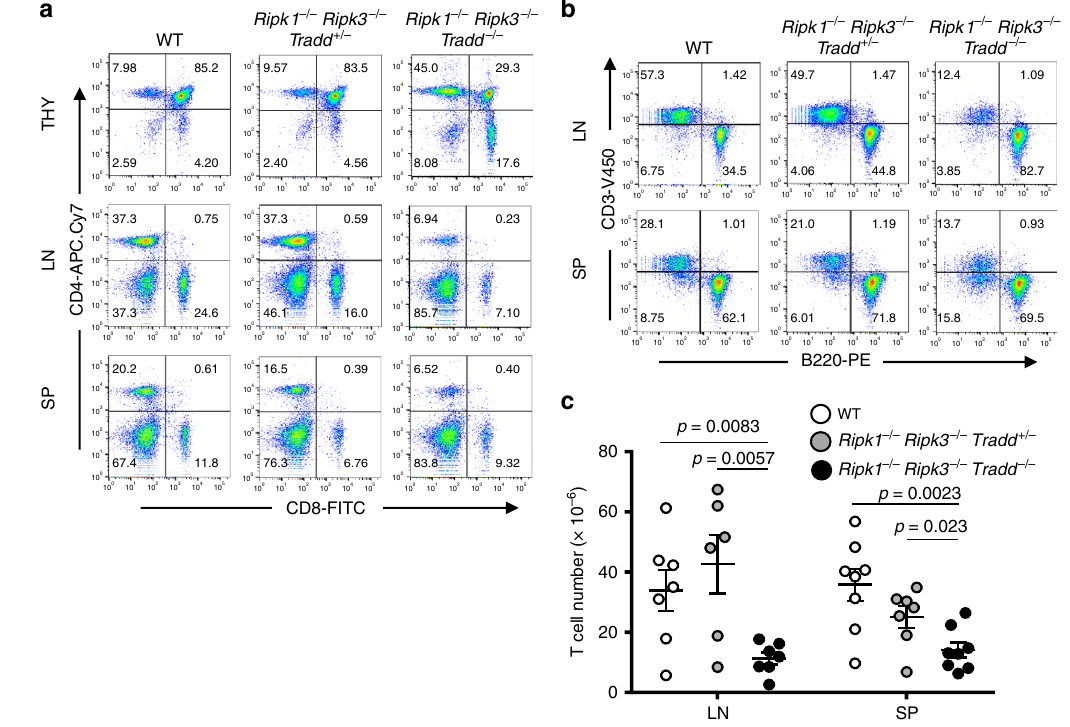
Fig. 3 Ripk1 − / − Ripk3 − / − Tradd − / − mice display impaired T cell development and T lymphopenia in young adulthood. a , b Representative two-color fl ow cytometric plots showing a CD4 + and CD8 + T cells in the lymph nodes, spleen, and thymus and b T cells (CD3 + ) and B cells (B220 + ) in the lymph nodes and spleen ( n = 8 independent experiments). c CD3 + T cell numbers in the lymphoid organs of 7 – 8 week old mice of indicated genotypes ( n = 7 independent experiments). All graphs presented as mean ±